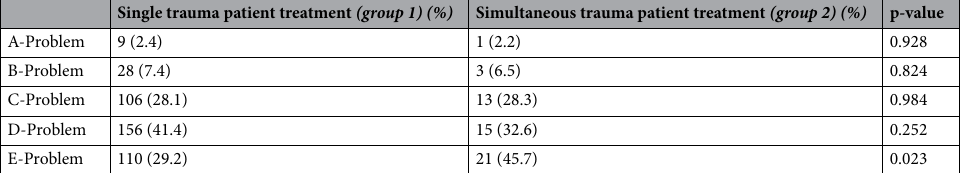
Table 4. Patients’ condition at admission to the Trauma suite (for definitions concerning the ABCDE-Status please refer Table